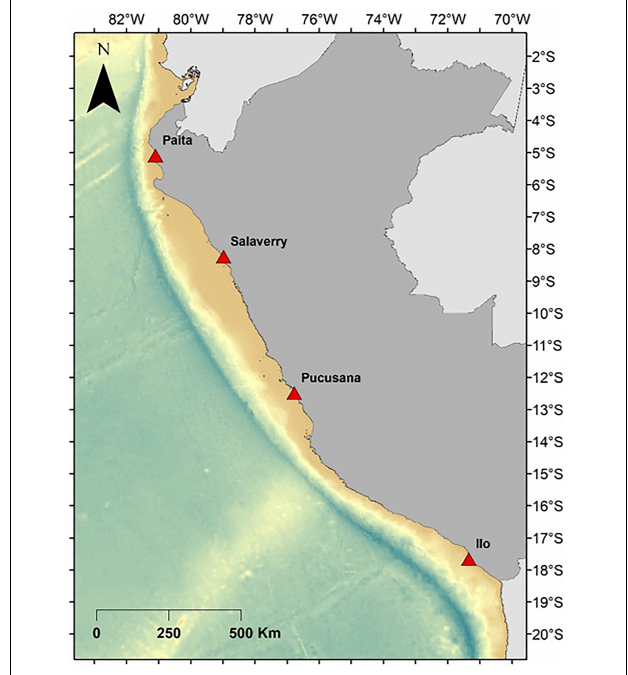
FIGURE 1 | Peruvian coastline with the four ports in which surveys were conducted. Salaverry and Pucusana were revisited for in-depth interviews.